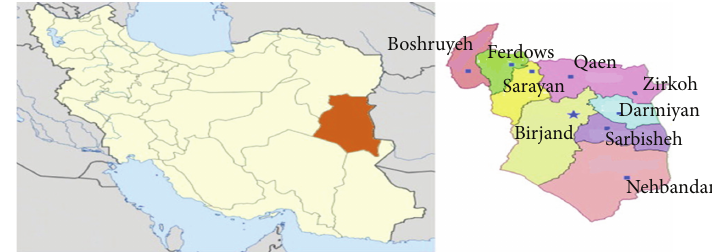
Figure 7: Iran: South